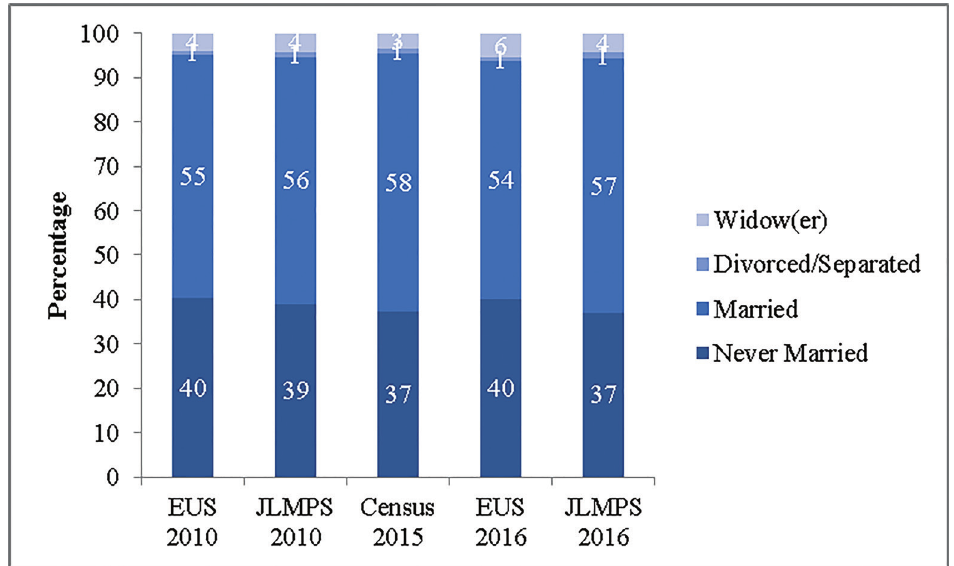
Marital status (percentage) by data source, Jordanians aged 15 years or older.